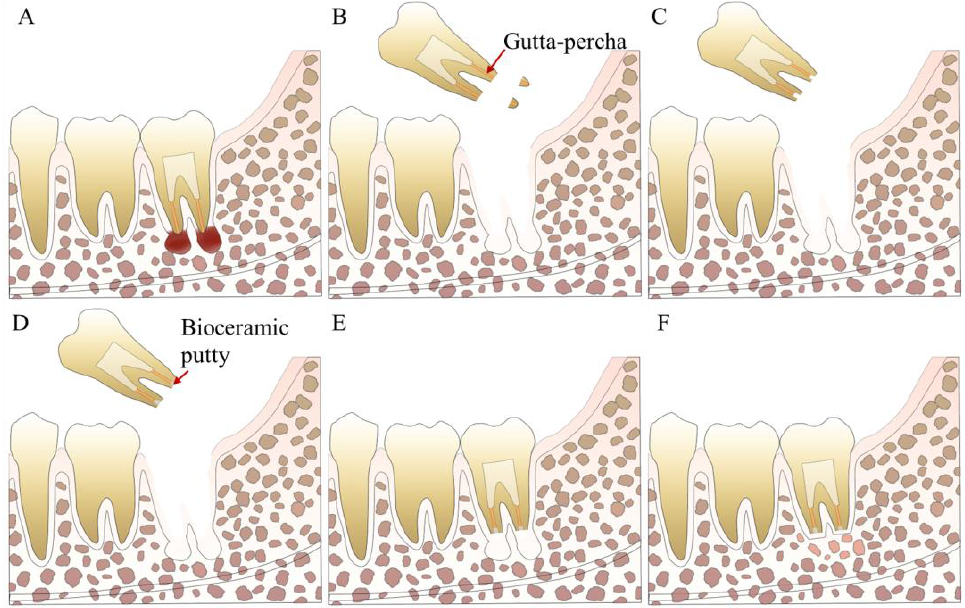
Figure 5. Treatment procedures for IR. ( A ) A tooth with refractory periapical disease. ( B ) Tooth extraction and root-end resection. ( C ) Root-end preparation. ( D ) Root-end filling with bioceramic putty. ( E ) Tooth replantation. ( F ) Apical inflammation disappears.